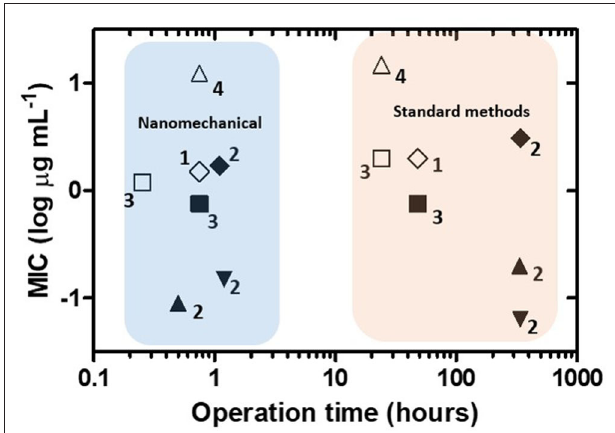
FIGURE 8 | Performance of nanomechanical sensors for antibiotic susceptibility testing. Operation time vs. minimum inhibitory concentration (MIC) plot for nanomechanical sensors and standard methods for the same antibiotics and bacterial strains. Symbols indicate each antibiotic/bacterial strain combination. Numbers correspond to references as follows: 1: Longo et al. (2013), 2: Mustazzolu et al. (2019), 3: Villalba et al. (2018), 4: Bennett et al. (2020).